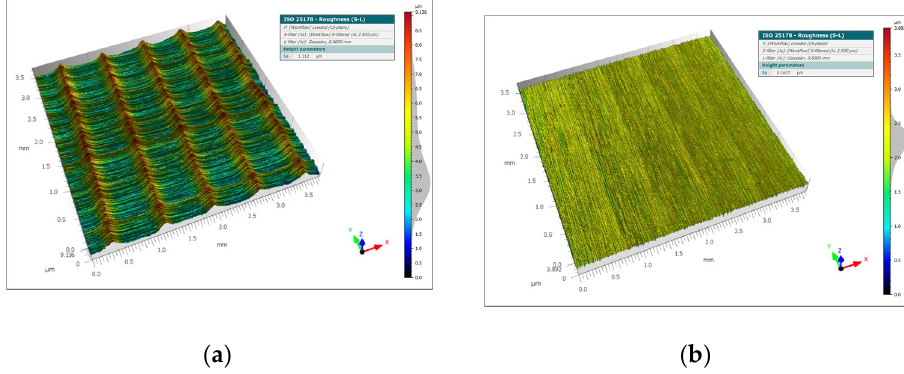
Figure 3. The roughness measurement of the 718H specimen: ( a ) Sa 1.11 μm before polishing and ( b ) Sa 0.16 μm after polishing.